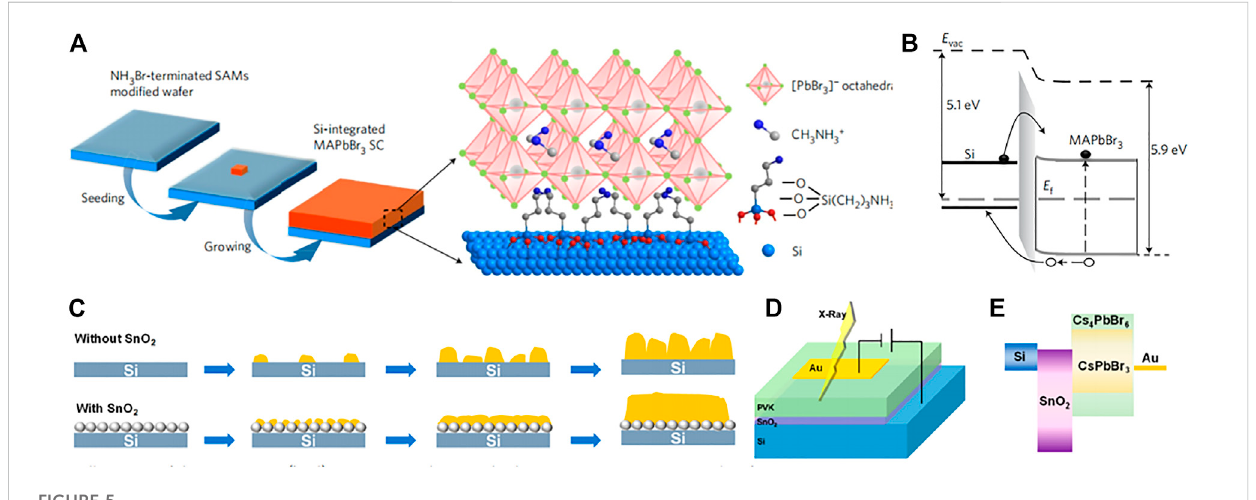
FIGURE 5 (A) Schematic diagram of fabrication of Si-integrated MAPbBr 3 single crystal device. (B) Band interface alignment of MAPbBr 3 and silicon. (C) Schematic illustration of perovskite chemical vapor deposition process with and without SnO 2 . (D) Device structure of SnO 2 /cesium-lead-bromide perovskite heterojunction and (E) energy level of the device. Reproduced with permission from Ref. [28] (A) (B) , Ref. [29] (C) (D) (E)